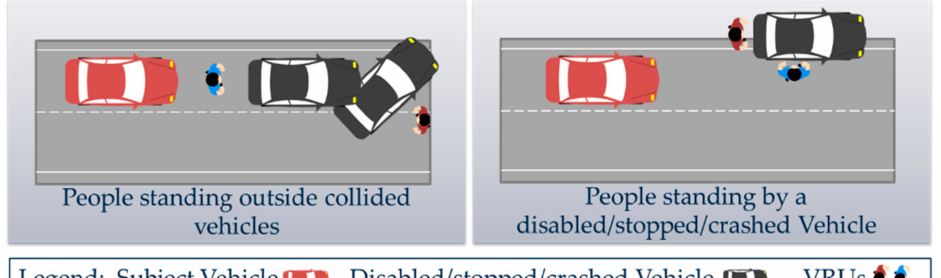
Figure 2. Left: Occupants alighted from or thrown out of vehicles involved in a multi-vehicle crash. Right: Occupants alighted from a disabled vehicle or a vehicle involved in a single-vehicle crash where they can be standing near or moving around the vehicle or injured and lying down on the road.